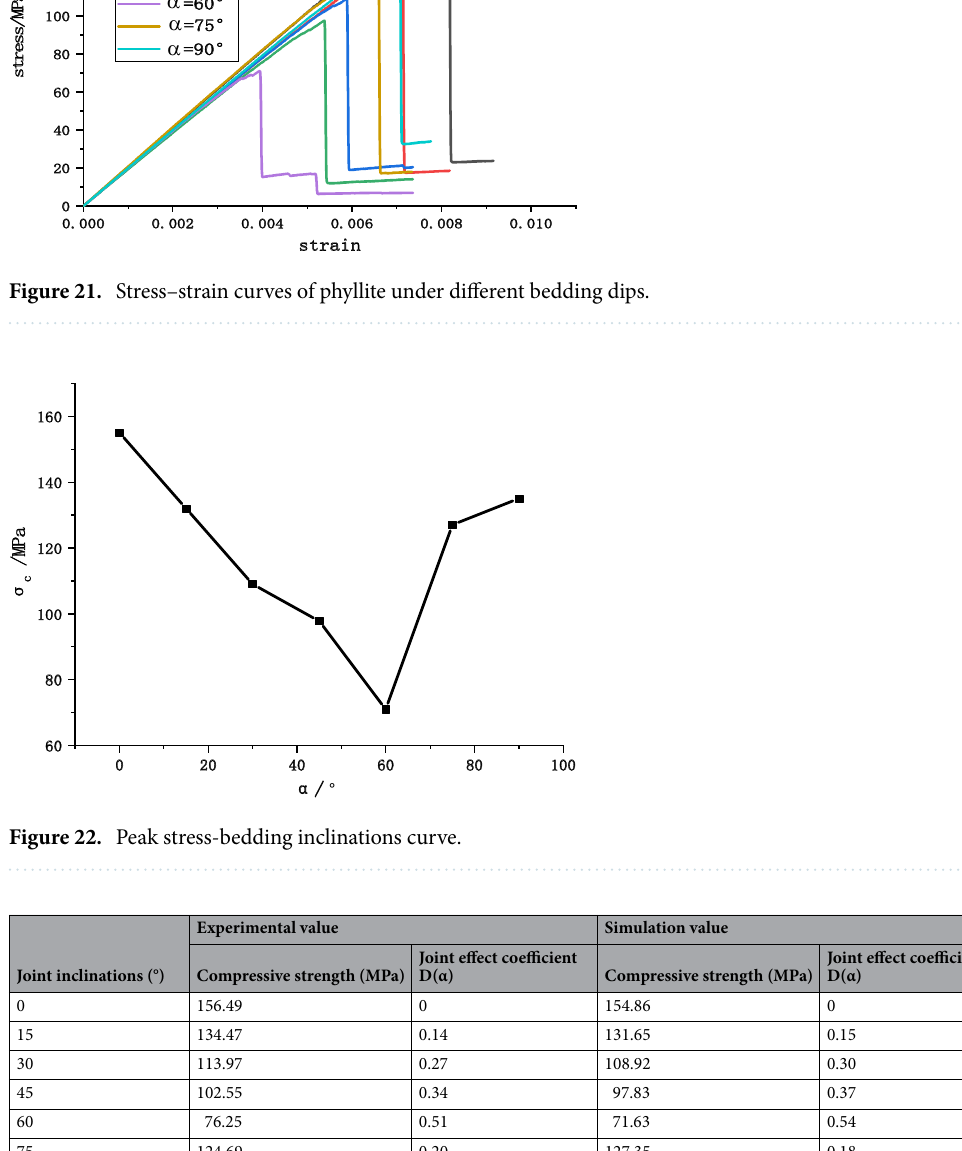
Table 3. Table of bedding effect coefficients of uniaxial compressive strength of phyllite.